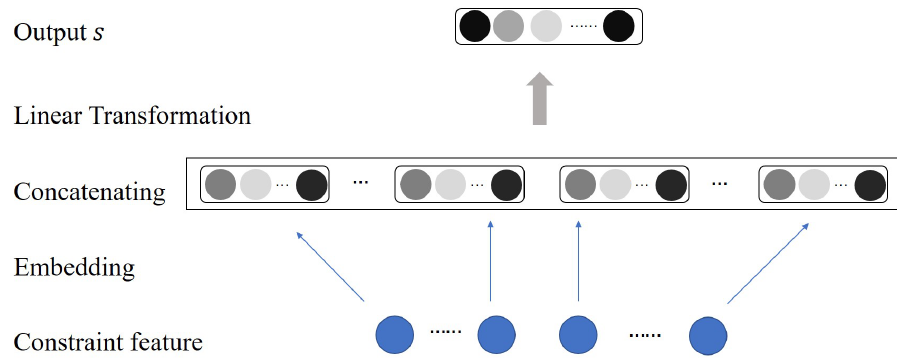
Figure 2. Process of the constraint net: this network is designed for extracting environmental con- straints. The embedded features are concatenated and activated to form a tensor for next